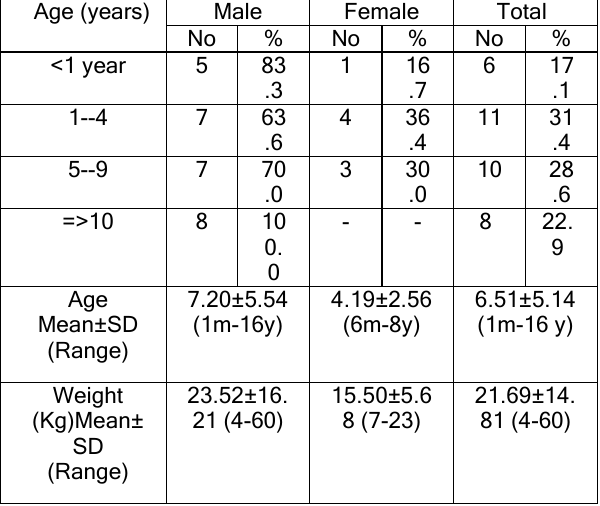
Table (2) : Pressure gradient (mm Hg) a cross the aortic